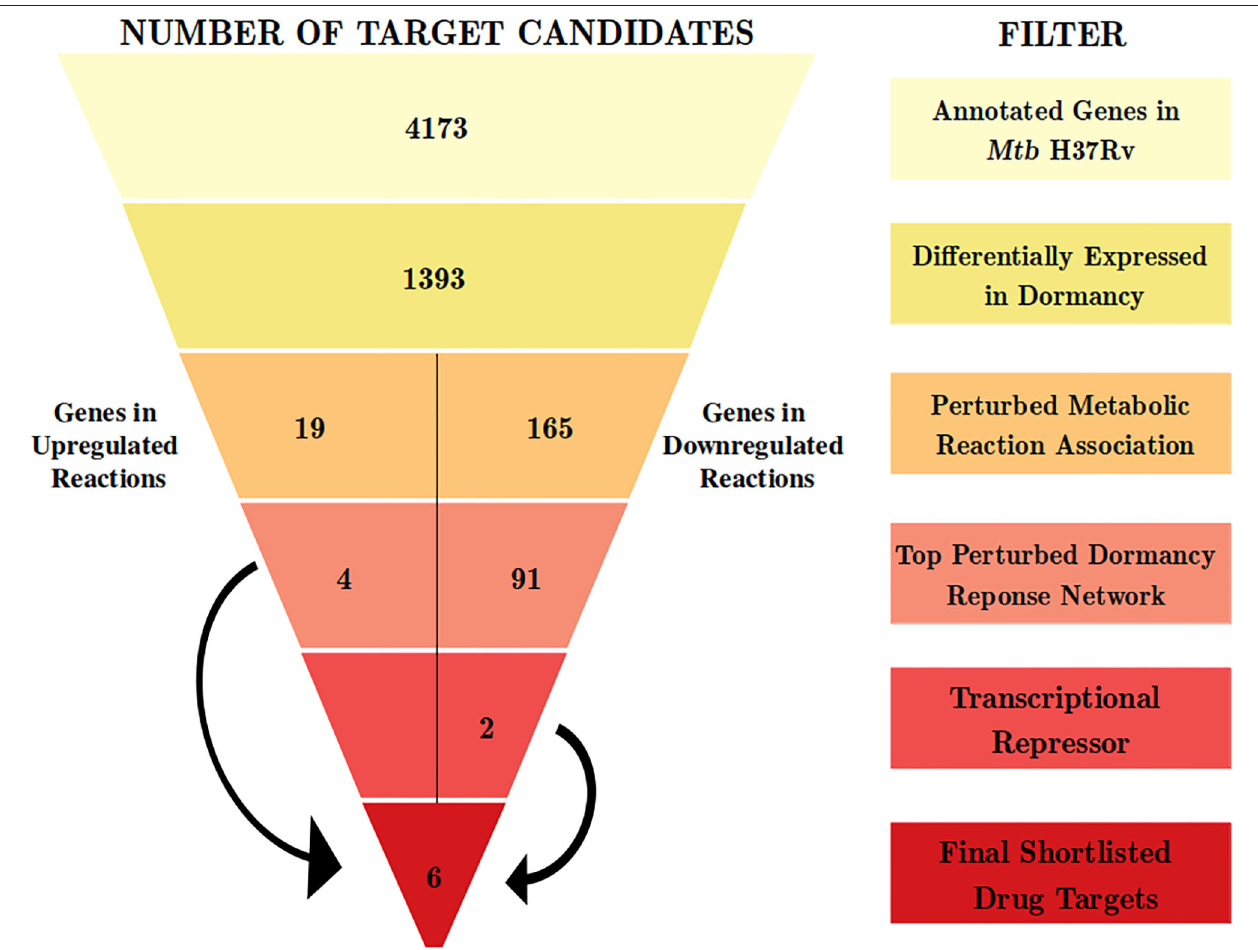
FIGURE 1 | The computational pipeline used for drug target candidate identification for latent tuberculosis. The pipeline involved stepwise filters based on gene expression, metabolic modeling, and protein-protein interaction network analysis to shortlist proteins crucial for Mtb dormancy. Six proteins were shortlisted as potential drug target candidates from this